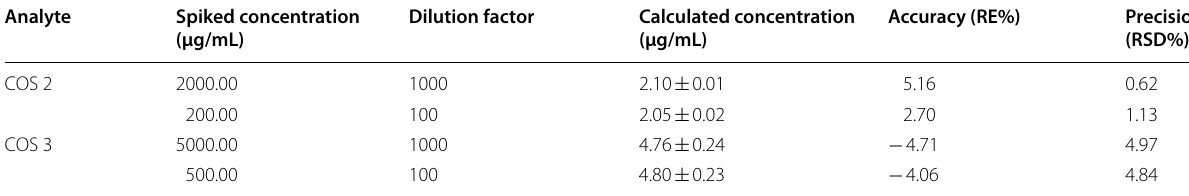
Table 5 The dilution effects of COS 2 and COS 3 in serum Analyte